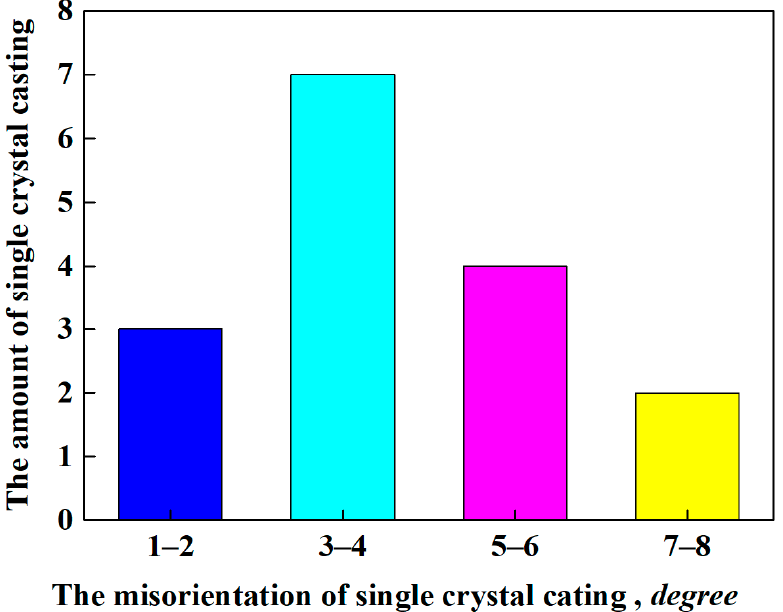
Figure 4. The statistical result of <001> direction of single crystal casting deviated from the direc- tional solidification.